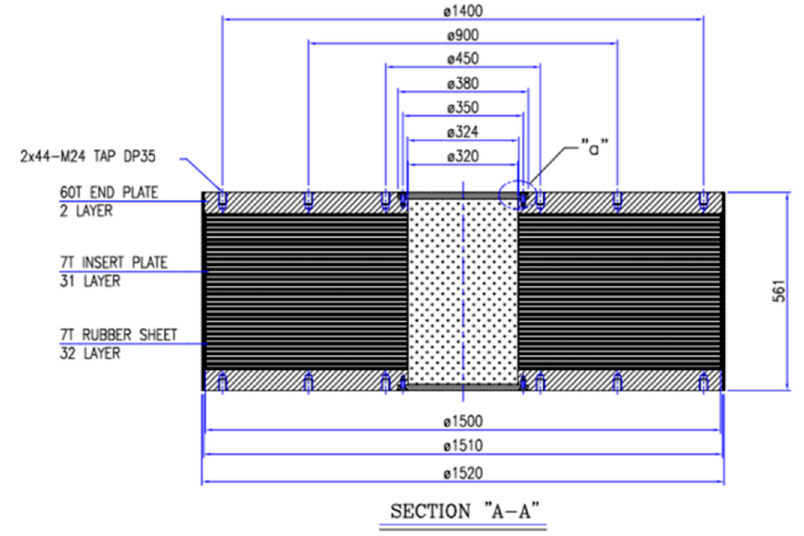
Figure 2. Dimensions of the test bearings (unit: mm).